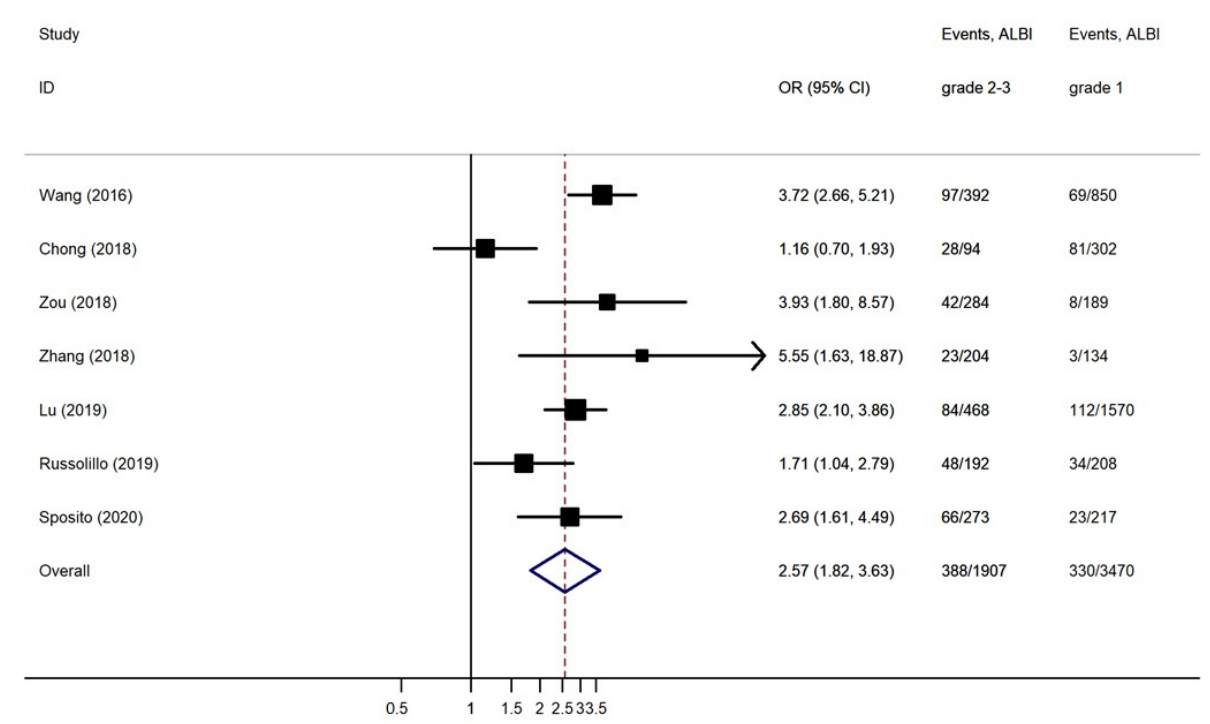
Figure 2. Forest plot of the pooled Odds Ratio (OR) for post-hepatectomy liver failure (PHLF) in ALBI grades 2 and 3 compared to ALBI grade 1. Events: PHLF/No PHLF; and CI: Confidence Interval.